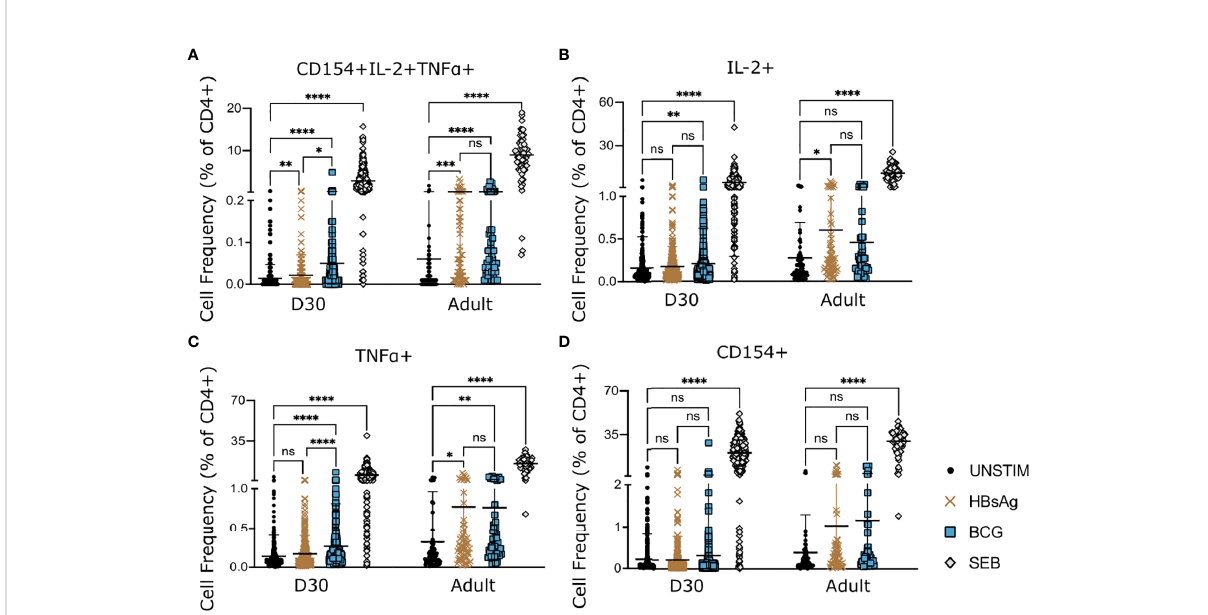
FIGURE 2 HepB- and BCG-speci fi c CD4 + T-cells in infant and adult samples. PBMCs from infants at D30 and adult donors (pooled data from 3 donors) were stimulated with HBsAg, BCG or SEB for 18hrs. Expression of activation markers CD154, IL-2 and TNF a , following stimulation was compared to background (unstimulated samples). Cell frequencies were analysed based on expression of all three markers (A) or total expression of one marker (B – D) . Kruskal-Wallis with Dunn ’ s post test, *p < 0,05; **p < 0,01; *** p < 0,005; **** p < 0,001; ns, not signi fi